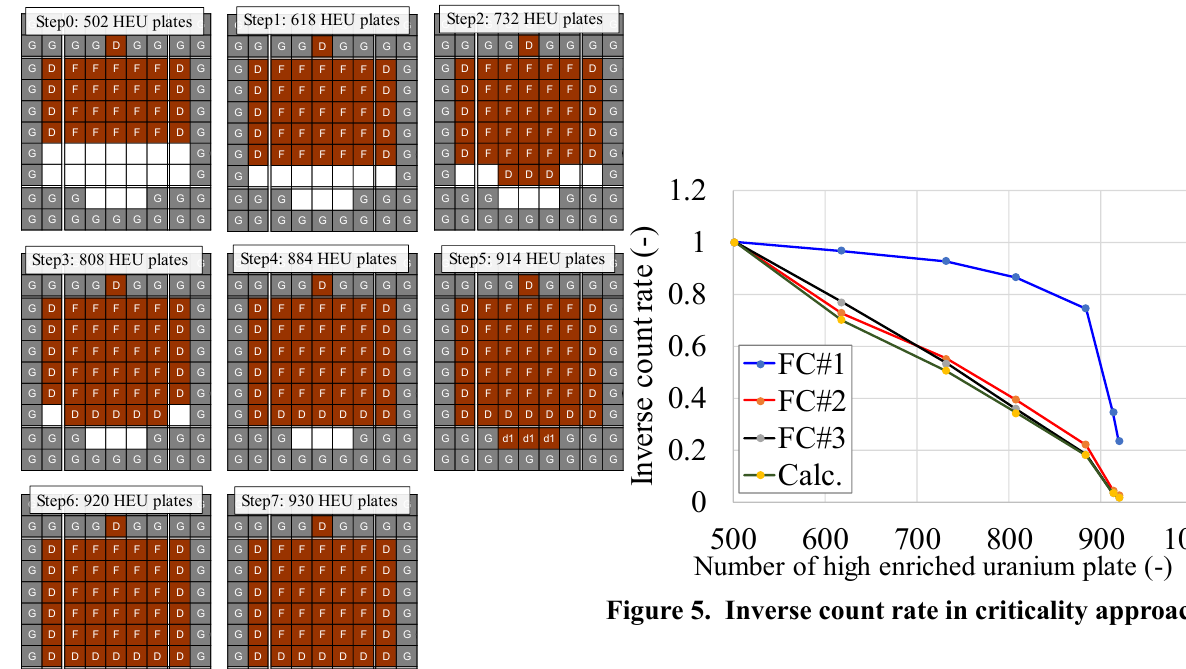
Figure 4. Process of criticality approach.